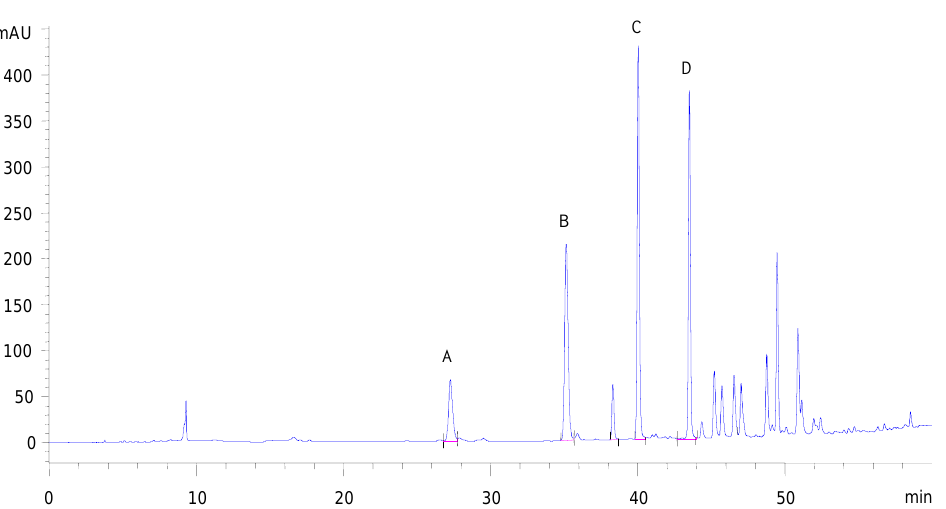
Figure 4. The chromatogram of oregano ether extract, as monitored by HPLC-DAD at 280